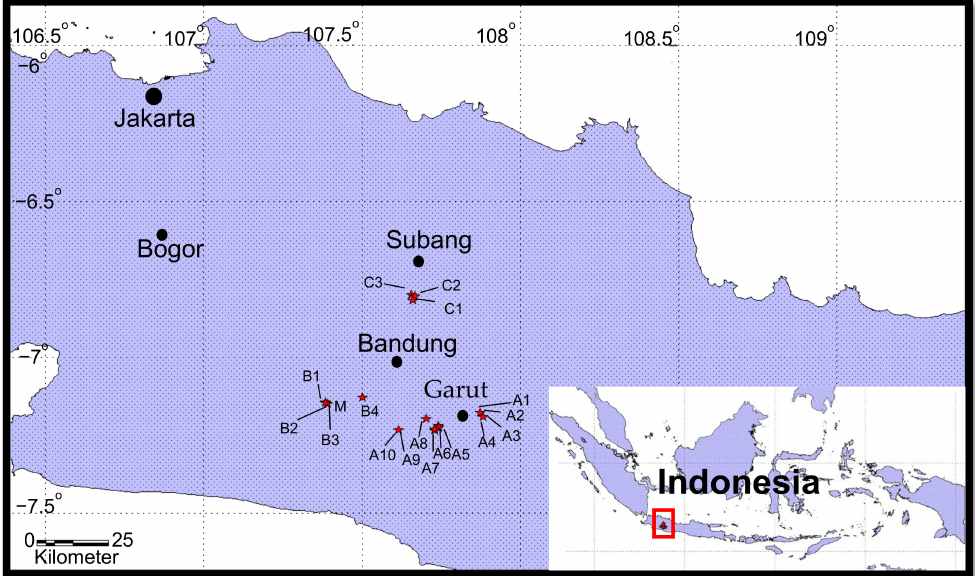
Figure 1. The study area, covering three cities: Bandung, Subang, and Garut. The black dots represent cities, and red asterisks indicate sampling